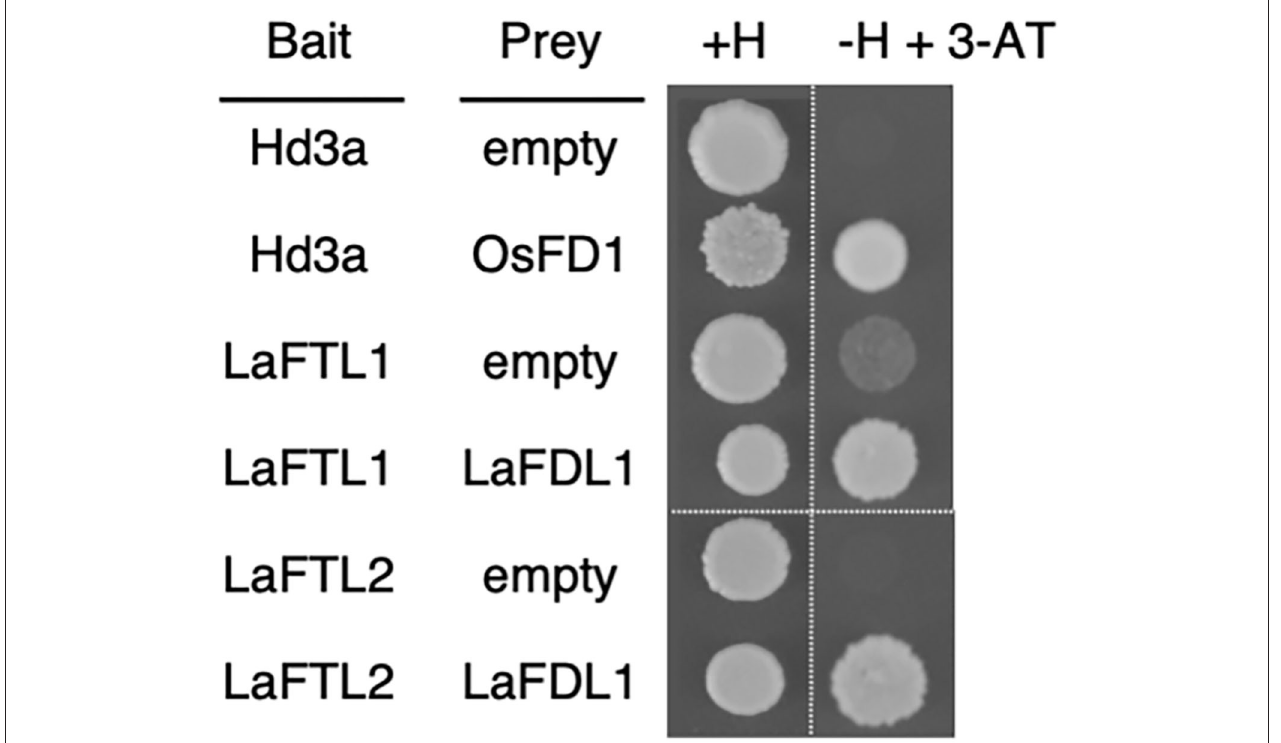
FIGURE 6 | Y2H. Yeast-two hybrid results showing interactions between LaFTL and LaFDL. Yeast growth on synthetic complete medium without uracil, tryptophan, and leucine (SC-UWL) agar media containing histidine ( + H) or lacking histidine plus 10mM 3-amino-1,2,4-triazole (-H + 3-AT) is shown. Rice Hd3a-OsFD1 was included as a